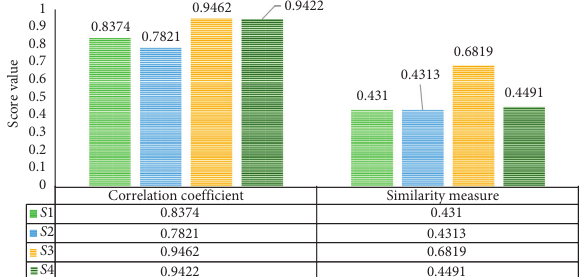
Figure 3: Alternative final score value with the proposed algorithms.